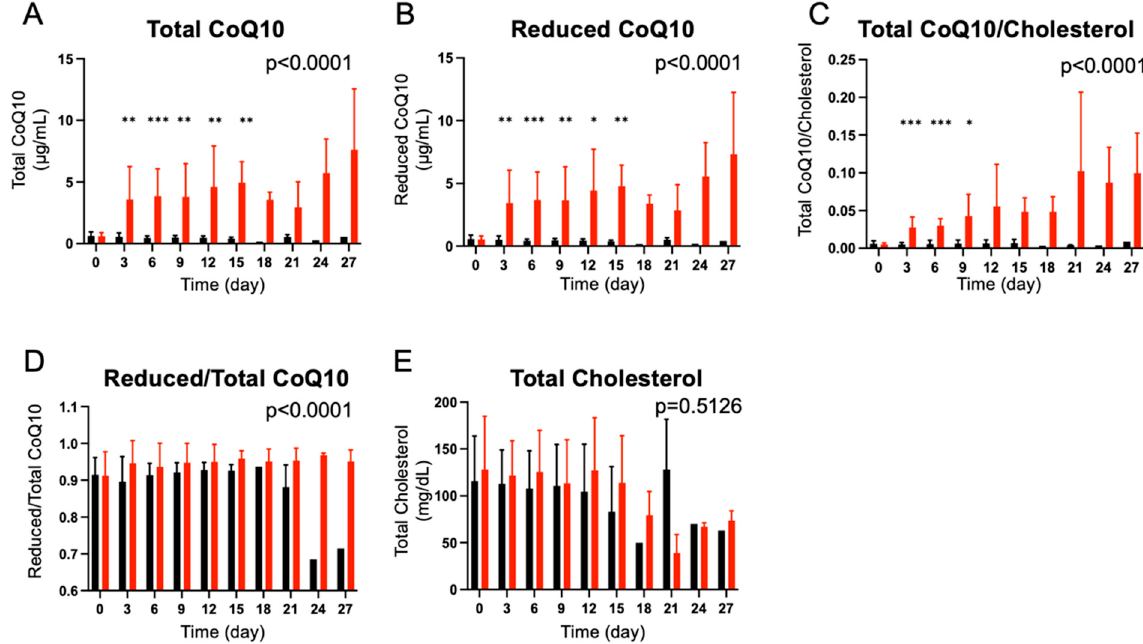
Figure 2. Effects of CoQ10 supplementation on plasma CoQ10 levels in burn patients. CoQ10 supplementation significantly increased plasma total CoQ10 concentrations ( A ), reduced CoQ10 concentrations ( B ), total CoQ10-to-total cholesterol ratio ( C ), and reduced-to-total CoQ10 ratio ( D ) compared with the placebo group. CoQ10 supplementation did not significantly alter total cholesterol concentrations ( E ). The p values in the figures indicate overall differences between the groups across the different time points that were analyzed using a longitudinal general linear mixed-effects model. The asterisks indicate p values between the groups at each time point, which were analyzed by Bonferroni’s multiple comparison test. Black bar: Placebo, Red bar: CoQ10, * p < 0.05, ** p < 0.01, *** p < 0.001 vs.